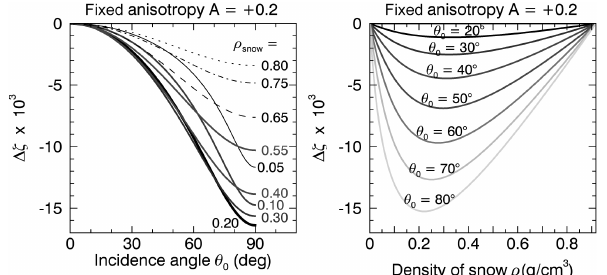
Figure 4. Specific path length difference (cid:49)ζ plotted over anisotropy for different snow densities but a fixed incidence angle, θ 0 = 30 ◦ (left panel), and for different incidence angles but a fixed snow den- sity, ρ = 0.25gcm − 3 (right